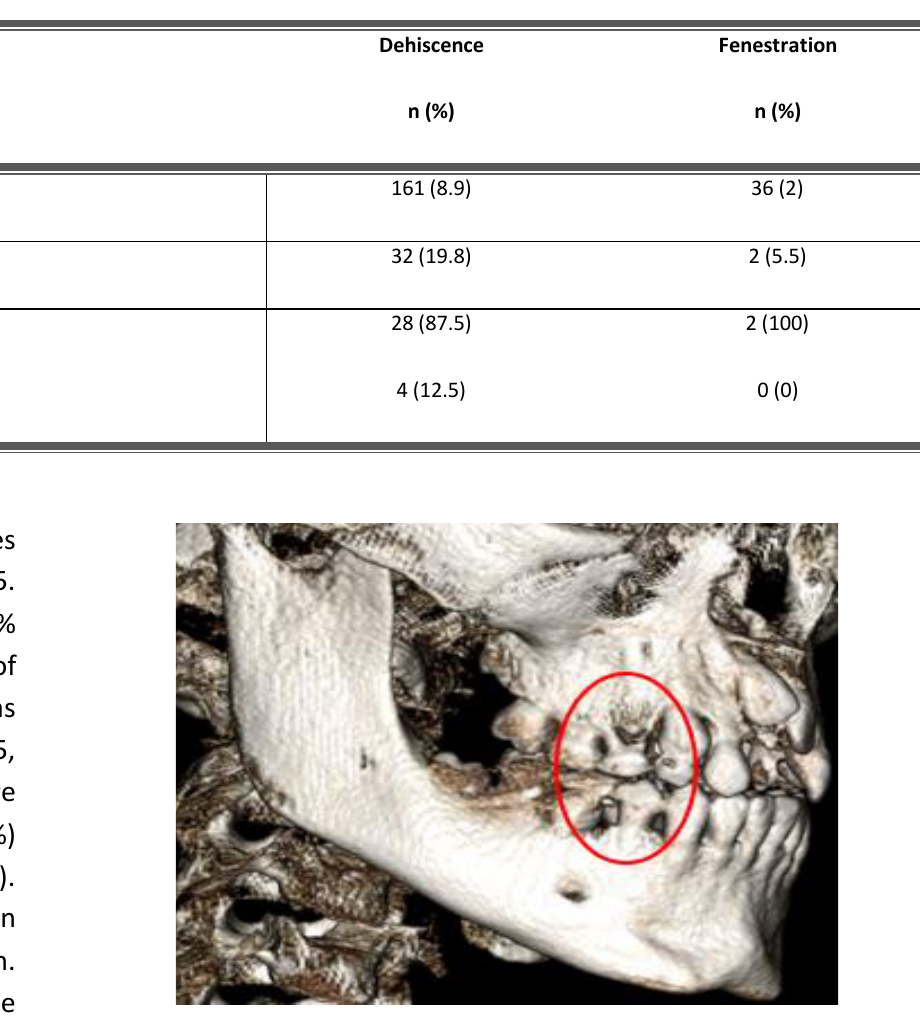
Figure 5. Dehiscence of different tooth